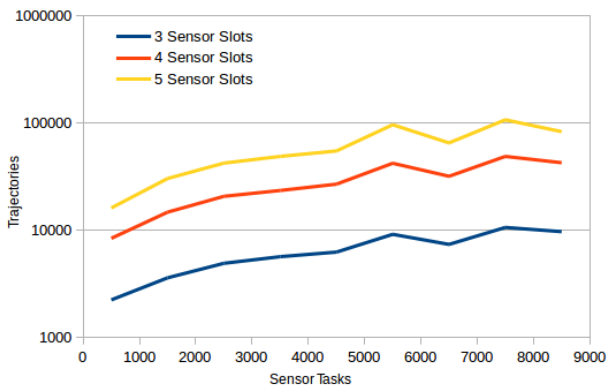
Figure 4. Number of created trajectories for different numbers of sensor tasks for UAVs with 3, 4, and 5 sensor slots. The number of trajectories is in log scale.